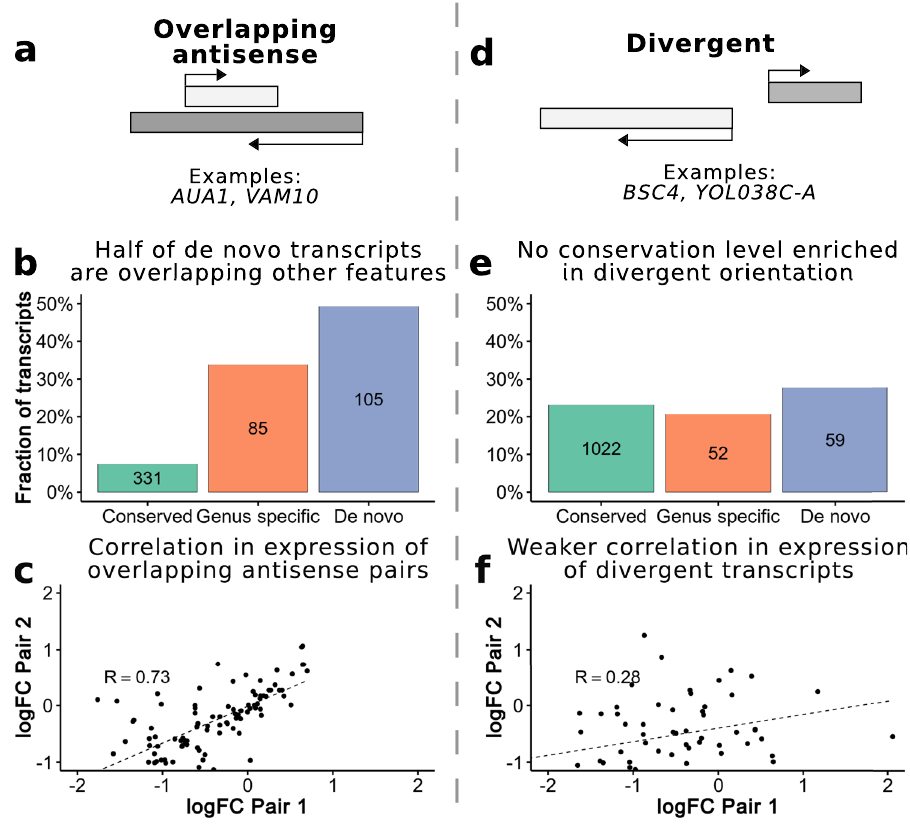
Fig. 5 Main classes of de novo transcripts in yeast. a Diagram of a pair of overlapping genes, which are on opposite strands. We consider all pairs of transcripts with any antisense overlap (no minimum overlap threshold). b Fraction of transcripts in each conservation level which overlap genes on the opposite strand. A higher proportion of de novo transcripts are in this orientation relative to more conserved transcripts. c Correlation fold change (FC) expression values overlapping genes. The differential expression (normal vs. oxidative stress) of gene pairs, which are overlapping each other on opposite strands is strongly correlated (R = 0.73 Spearman ’ s correlation, p -value < 10 − 5 ) suggesting they may be co-regulated. d Diagram of a divergent pair of gene. The genes are in a head-to-head orientation on opposite strands and can share a single bidirectional promoter. We considered transcripts separated by 1-400nt to be divergent. e Fraction of transcripts in each conservation level, which are in a divergent orientation. f Correlation FC expression values divergent genes. The differential expression (normal vs. oxidative stress) of divergent gene pairs is only weakly correlated (R = 0.28 Spearman ’ s correlation, p -value = 0.02754). Source data are provided as a Source Data fi